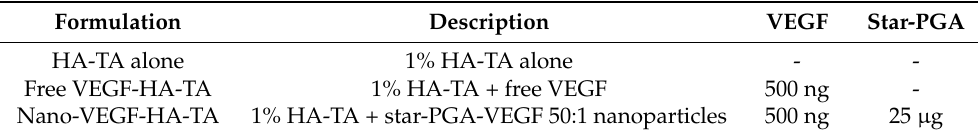
Table 1. Formulations tested in the chick chorioallantoic membrane study and the amounts of star-polyglutamic acid (PGA) or vascular endothelial growth factor (VEGF) per 200 µ L gel portion for each. Free VEGF refers to the VEGF in the HA-TA hydrogel that is not encapsulated in a nanoparticle.